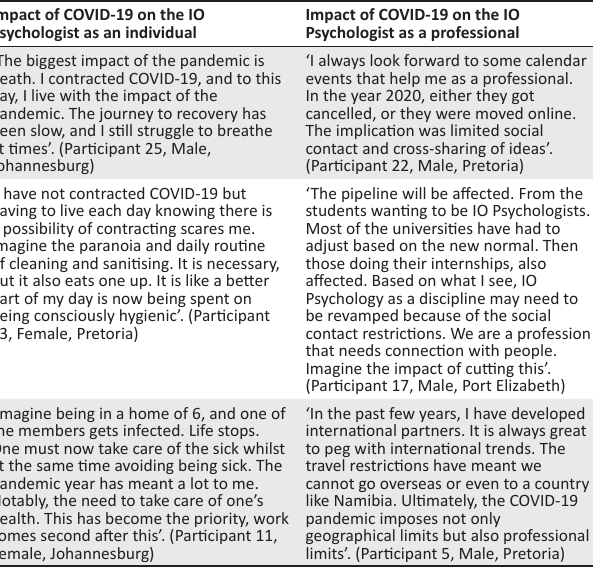
TABLE 3: Impact of COVID-19: Illustrating